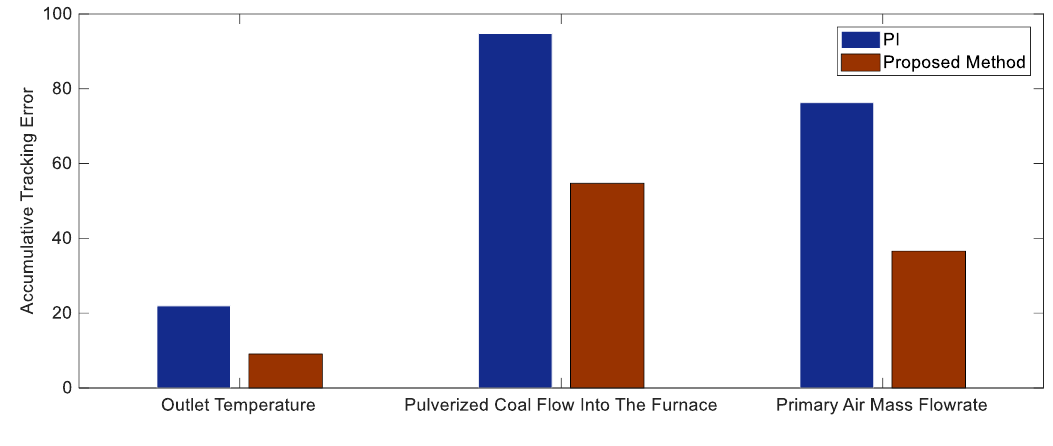
Figure 13. Cumulative tracking error.